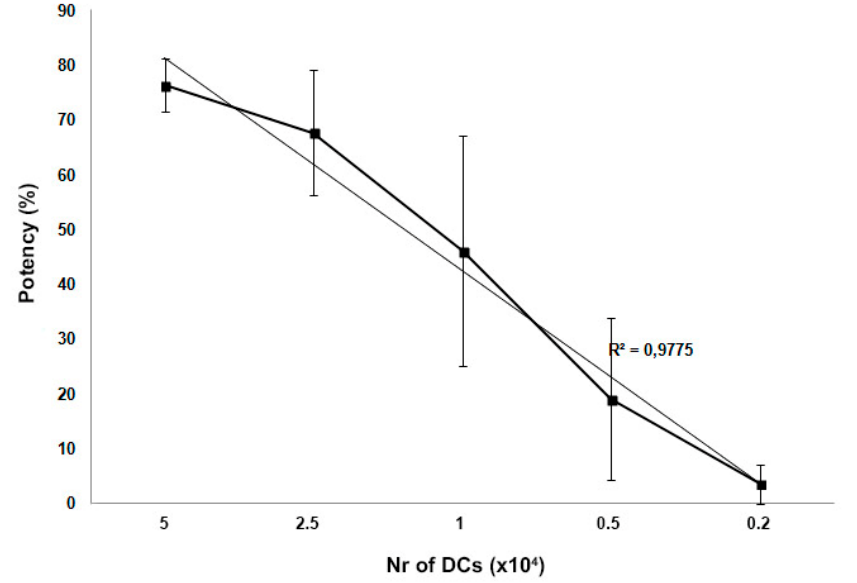
Figure 5. Linearity of the method. Dose response of varying numbers of DCs co-cultured with CD3+ T cells (1 × 10 5 ) and its linear regression line are reported. Results are reported as mean ± SD obtained from three different batches of DCs.